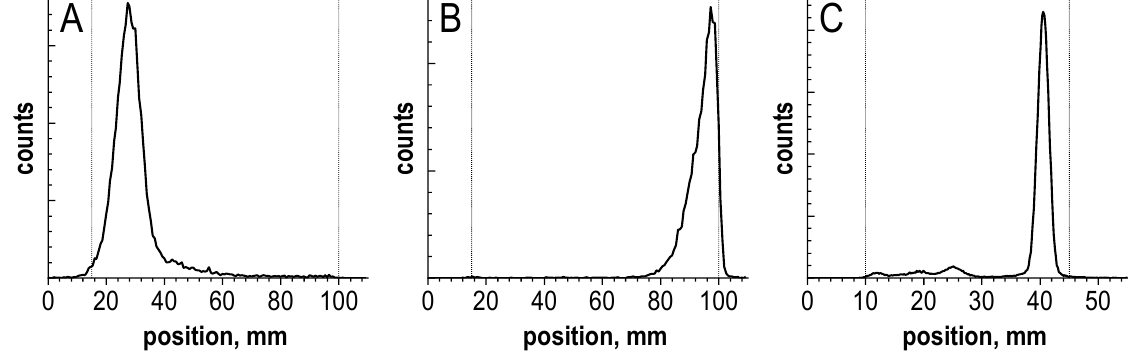
Figure 3. Radio-TLC chromatograms of 4.8 GBq [ 177 Lu]Lu-PSMA-617 preparation (sample volume— 1 mL, 100 µ g of PSMA-617, pH 4.5, synthesis at 95 ◦ C for 30 min) obtained with different TLC methods (see Section 4): ( A ) method 1 ( Rf for [ 177 Lu]Lu-PSMA-617 is 0.15 ± 0.05), ( B ) method 2 ( Rf for [ 177 Lu]Lu-PSMA-617 is 0.95 ± 0.05), ( C ) method 3 ( Rf for [ 177 Lu]Lu-PSMA-617 is 0.85 ± 0.05).